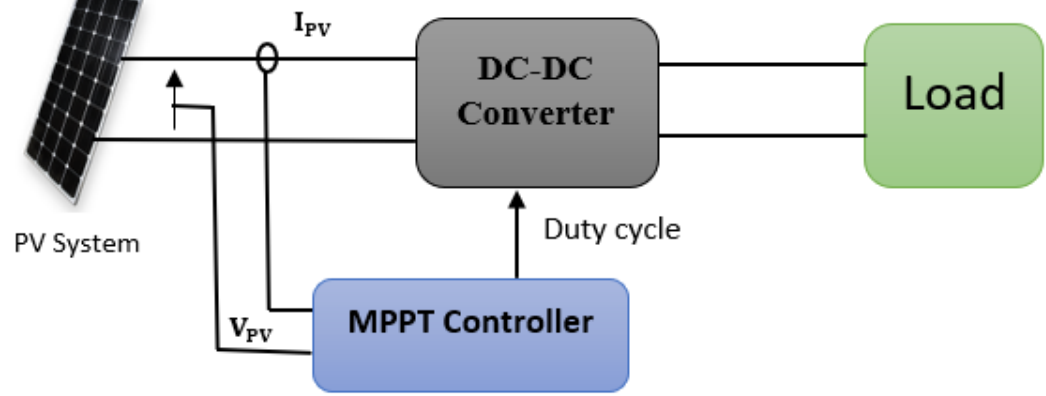
Figure 1 : Synoptic diagram of the photovoltaic